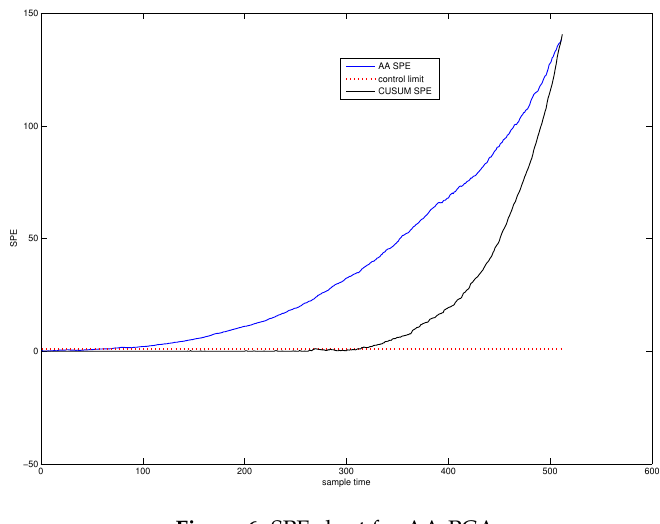
Figure 6. SPE chart for